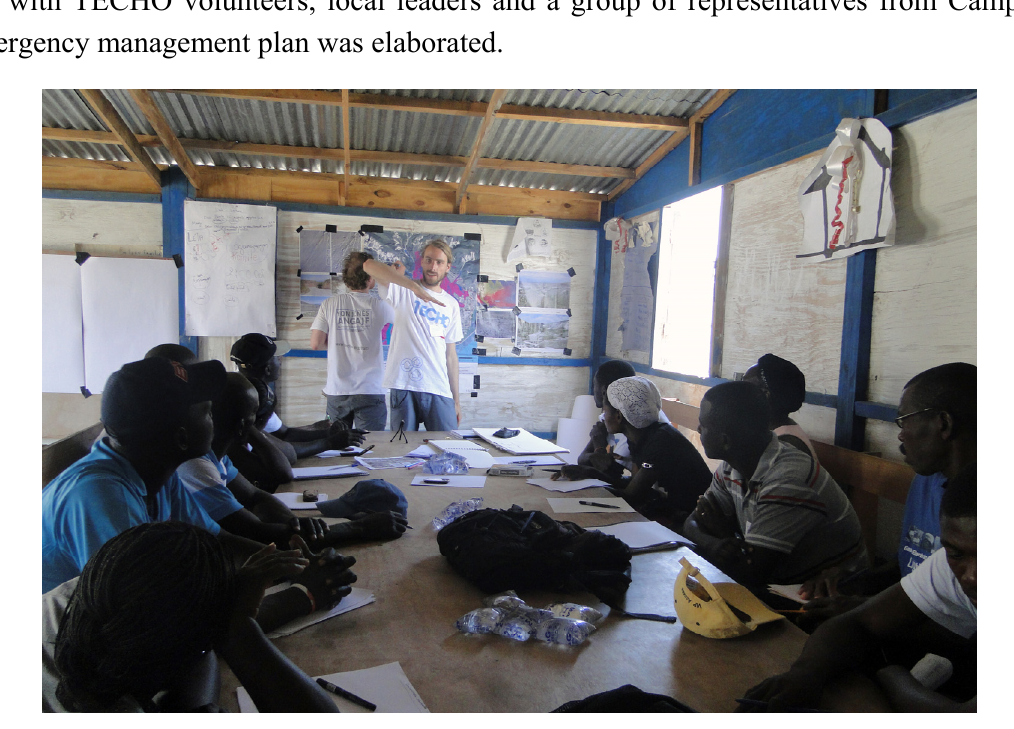
Figure 18. In a flood risk workshop, the hazard situation was presented and discussed with a group of community leaders from Onaville and nearby Camp